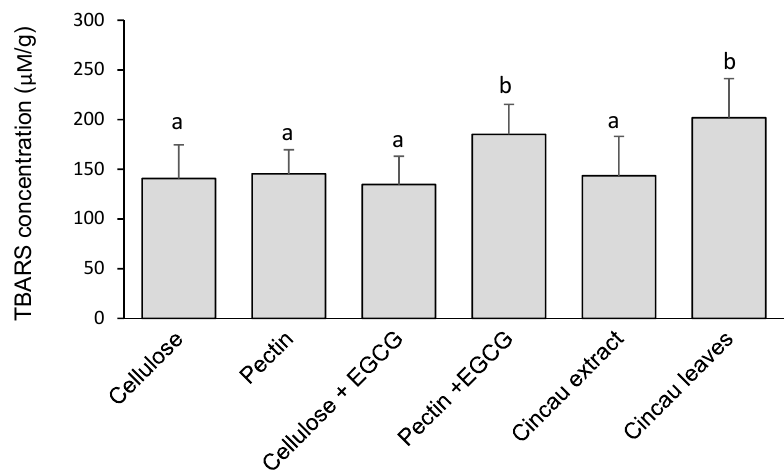
Figure 3. Effects of different diets on thiobarbituric acid reactive substance (TBARS) concentration in the livers of rats six weeks after the second AOM injection (2 × 15 mg/kg). Values are the mean ± SE ( n = 10). Means with a different letters on the bar are statistically significantly different ( p ≤ 0.05). EGCG, 0.1% epigallocatechin ‐ 3 ‐ gallate.